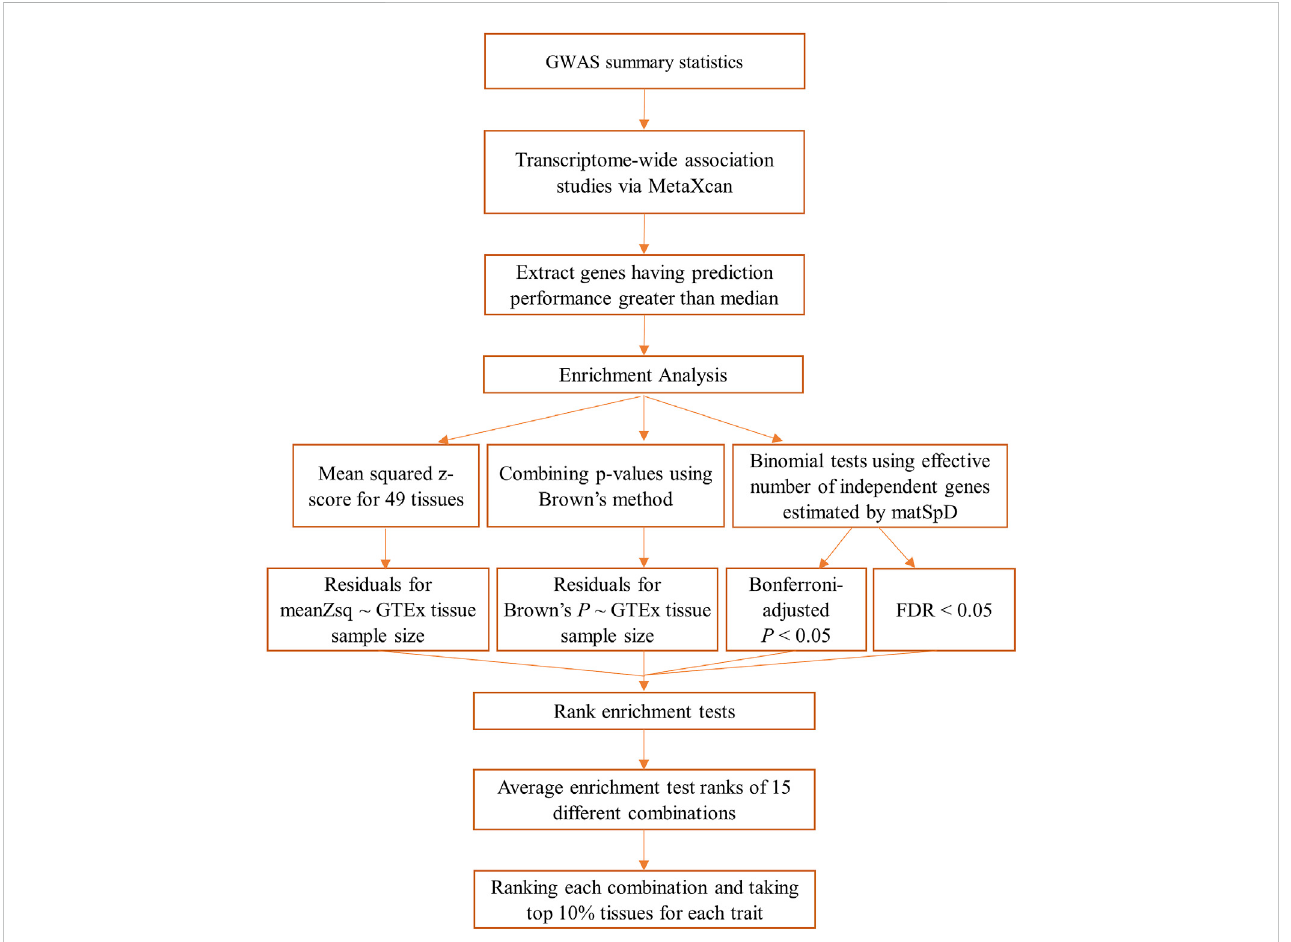
FIGURE 1 Overview of the methodology followed for each of the 29 GWAS datasets used in this